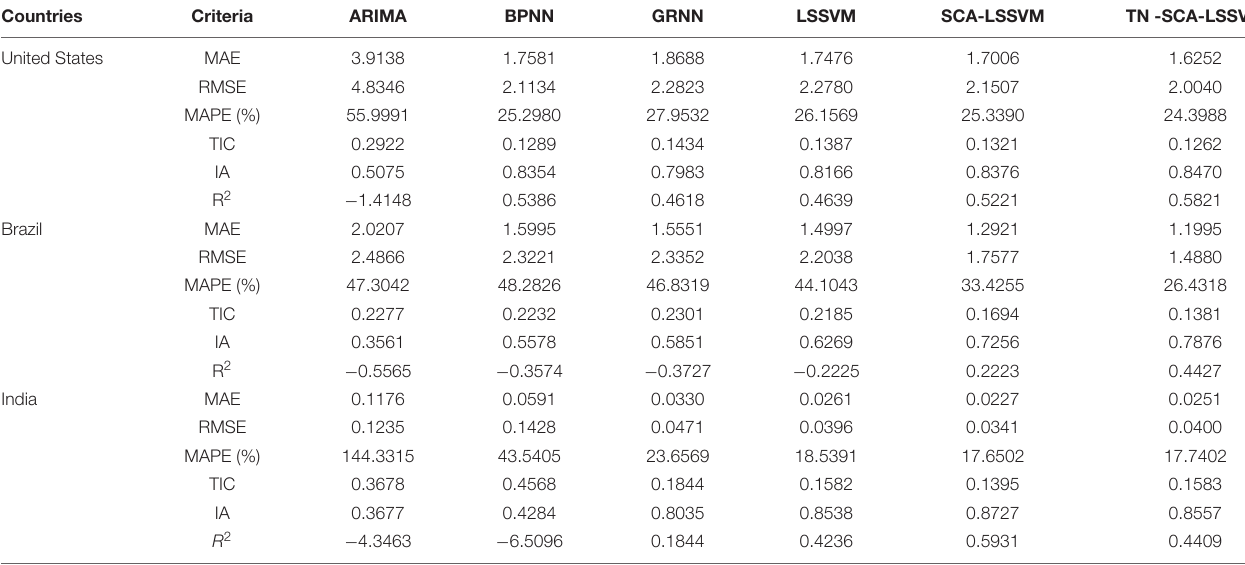
TABLE 6 | The comparative forecasting error of different models for COVID-19 new death cases.